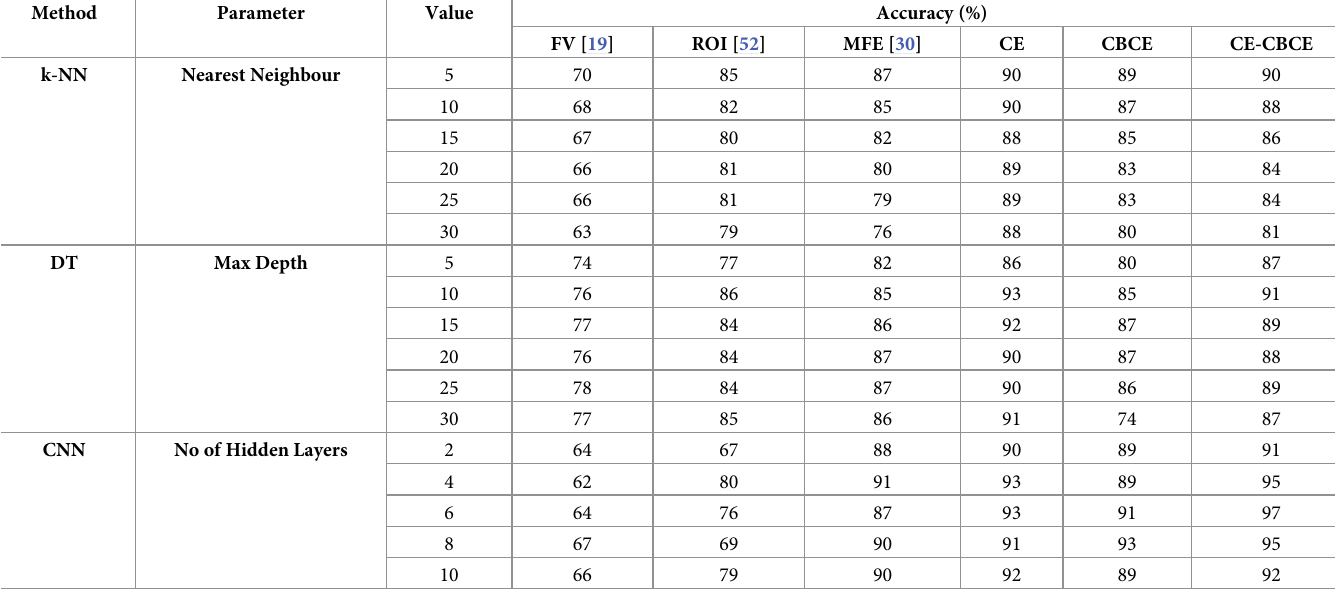
Table 4. Accuracy results comparison of ROI, FV, MFE, CE, CBCE and CE-CBCE. Method Parameter